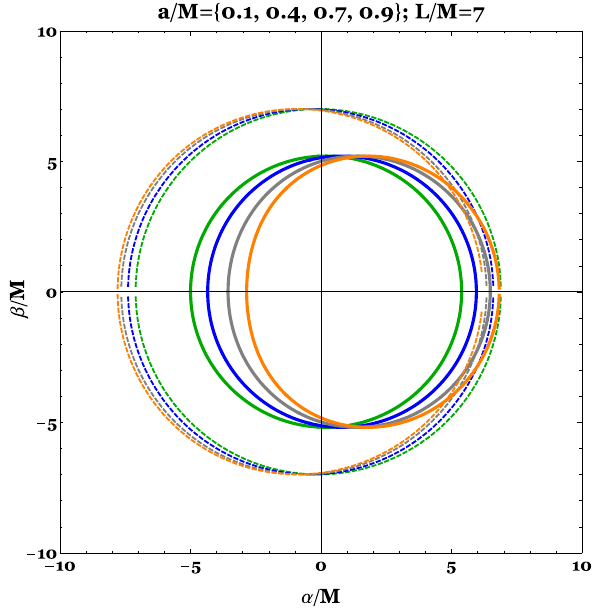
Fig. 2 Silhouette of the shadow cast by the rotating polytropic BH for L / M = 7 with a / M = 0 . 1 (green), a / M = 0 . 4 (blue), a / M = 0 . 7 (grey), a / M = 0 . 9 (orange). The dashed lines corresponds to the polytropic BH while the solid ones indicate the behaviour of a Kerr solution